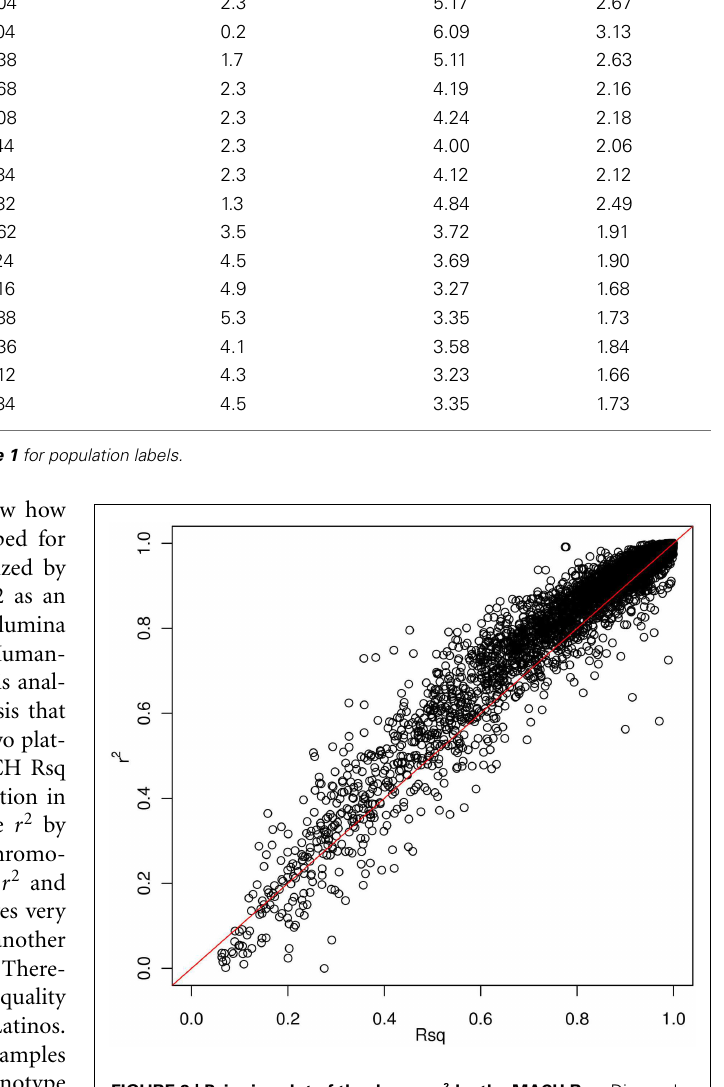
FIGURE 2 | Pairwise plot of the dosage r 2 by the MACH Rsq. Diagonal line (red) is a perfect match between the MACH Rsq and the dosage r 2 . Further off the diagonal line means poorer estimate.The correlation coefficient between Rsq and r 2 is